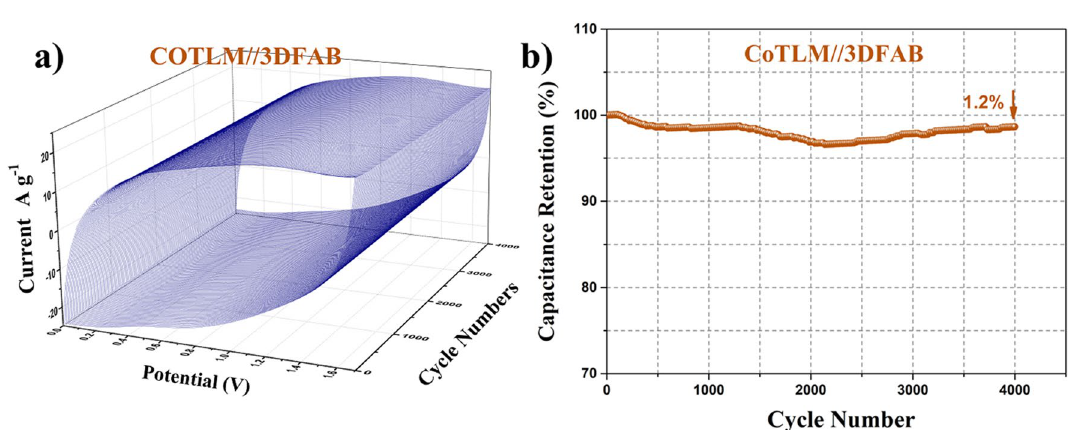
Figure 10. 3DFAB//CoTLM asymmetric systems measured at a scan rate of 50 mV s −1 ( a ), variation of the specific capacitance of the 3DFAB//CoTLM cell with CCV method as a function of the number of cycles at 50 mV s −1 ( b